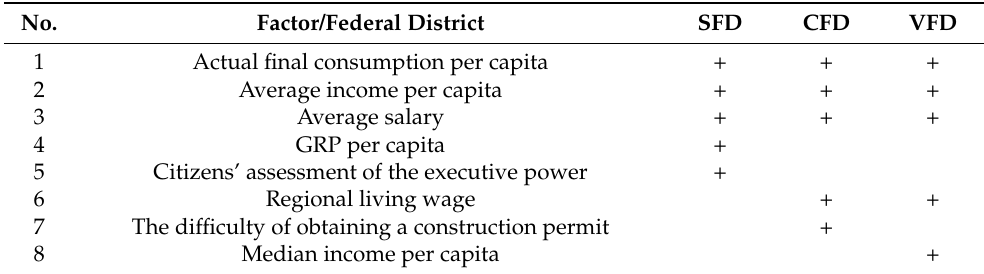
Table 1. TOP-5 factors of influence on the regional housing and communal services in the Southern Federal District, Central Federal District and Volga Federal District.